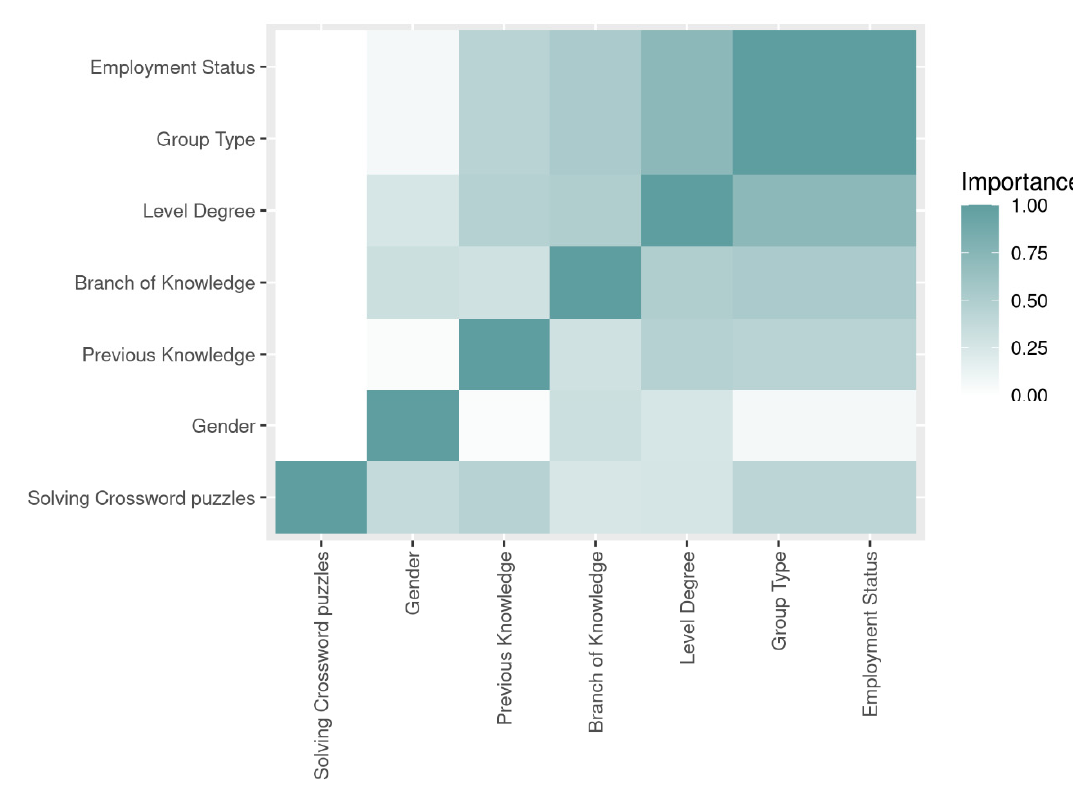
Figure 6. Relationship matrix on the selected characteristics performed with the chi-square algorithm.